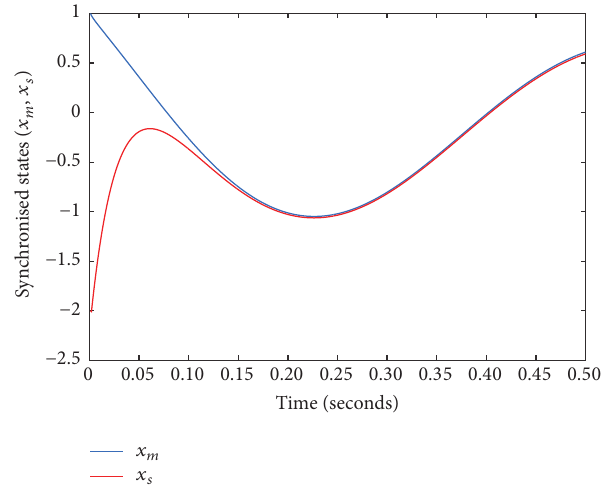
Figure 11: State synchronization ( 𝑥 𝑚 , 𝑥 𝑠